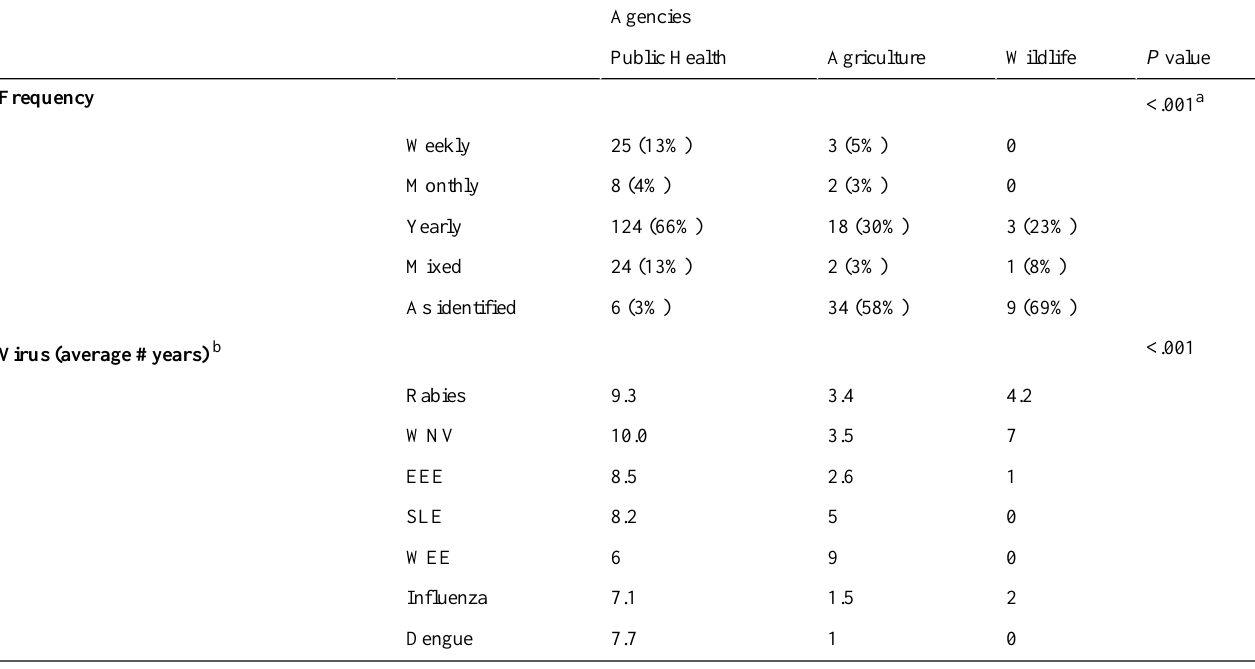
Table 3. Comparison by agency type: The number of states that provided zoonotic viruses data on websites by frequency as well as the average duration of years the data is provided by virus, 2000-2012 (viruses chosen from Figure 1; frequency P value determined by Fisher’s Exact test and virus P value determined by ANOVA; percentages might not add to 100% due to rounding).